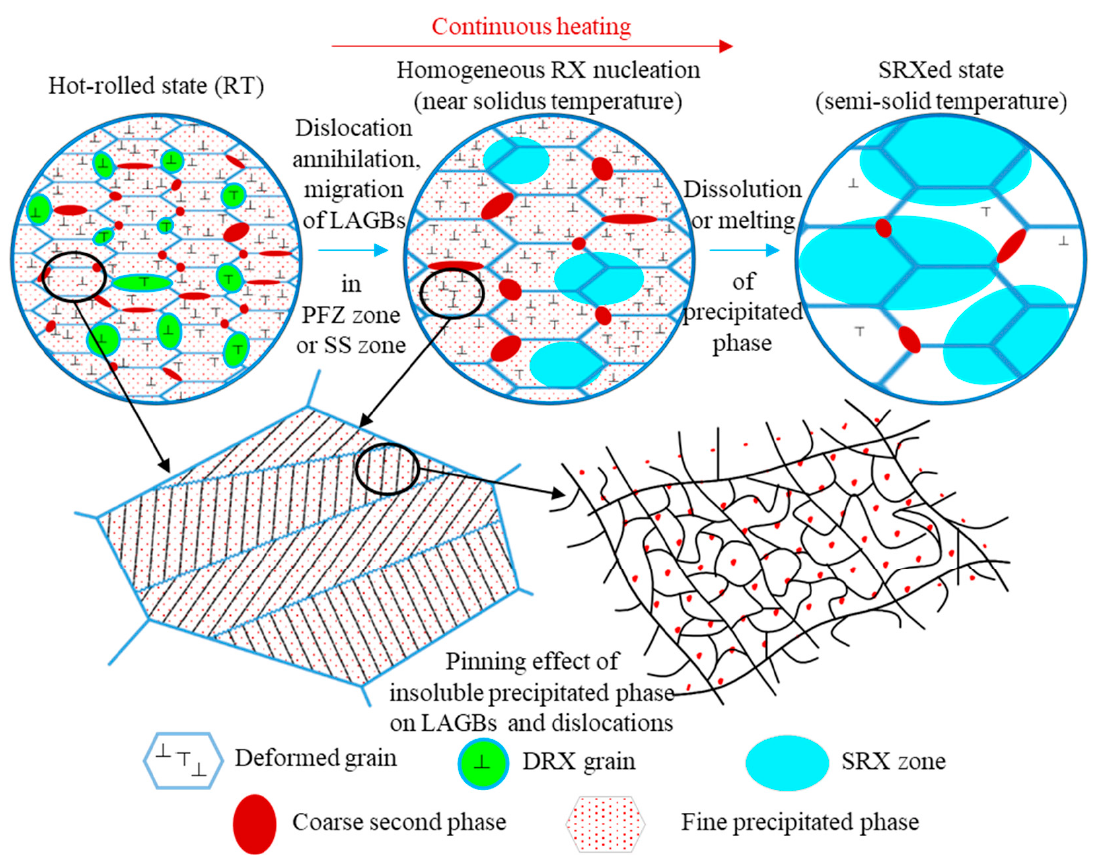
Figure 13. Schematic diagram of the recrystallization mechanism during semisolid annealing of hot-rolled 2A14 Al alloy.